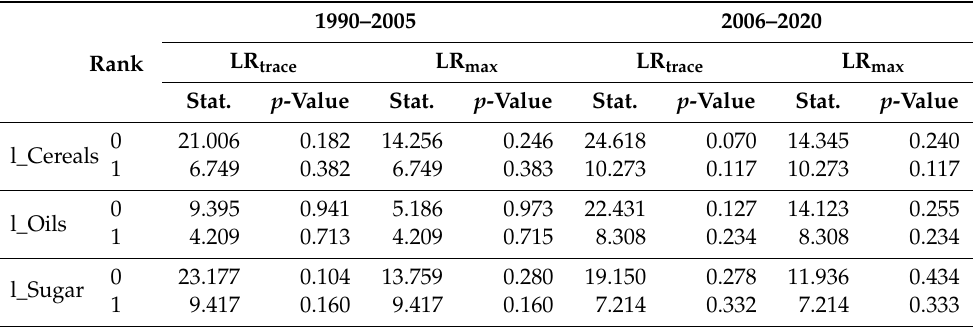
Table 4. Cointegration results for oil and food price indices.